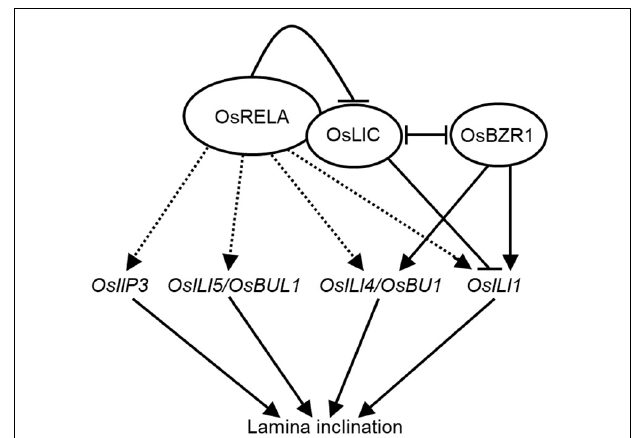
FIGURE 7 | A model for OsRELA in regulating the lamina inclination. OsRELA positively regulates the expression of OsIIP3, OsILI5/OsBUL1, OsILI4/OsBU1 , and OsILI1 , which are positive regulators involved in the lamina inclination. Since it has been reported that OsBZR1 and OsLIC are pair of antagonistic transcription factors that involved in the lamina inclination by regulate the expression of OsILI1 . The binding of OsRELA can activate the expression of OsILI1 repressed by OsLIC as well. Whether the OsRELA directly or indirectly activates the listed gene expressions (dashed arrows) should be elucidated in the